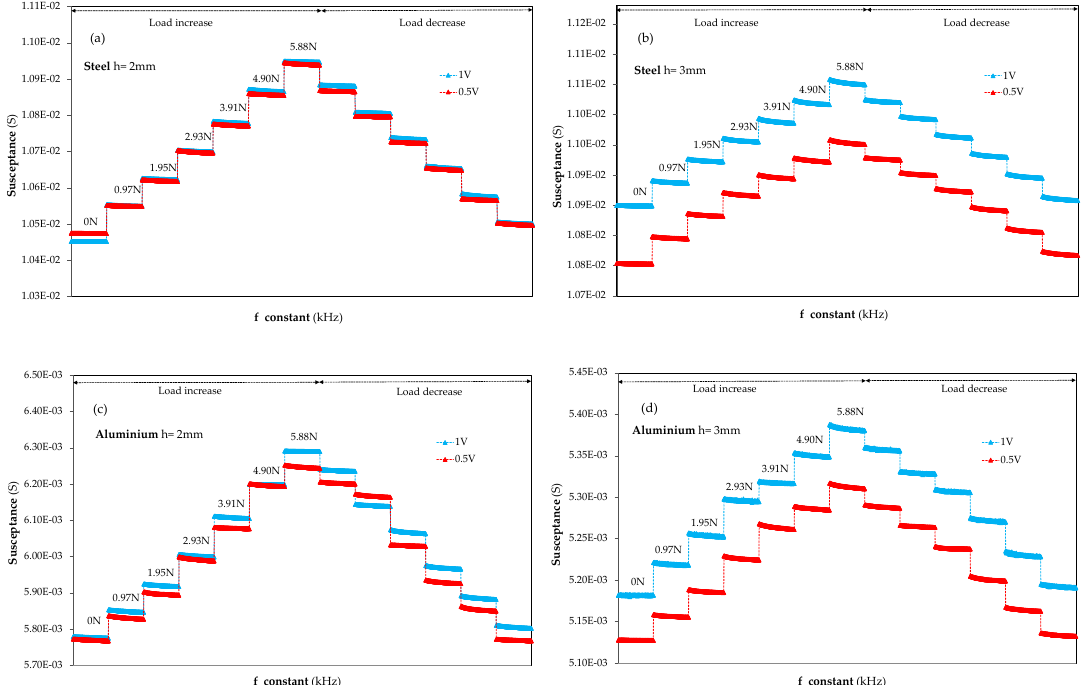
Figure 8. Excitation voltage influence on the time domain susceptance behavior at the optimal frequency, f optimal, steel = 300 kHz and f optimal, aluminum = 150 kHz, for ( a ) steel h = 2mm, ( b ) steel h = 3mm, ( c ) aluminum h = 2mm, ( d ) aluminum h= 3mm.